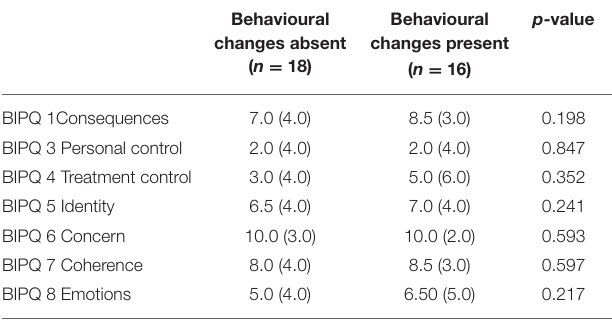
TABLE 2 | BIPQ scores of the cohort stratified by behavioural change status.